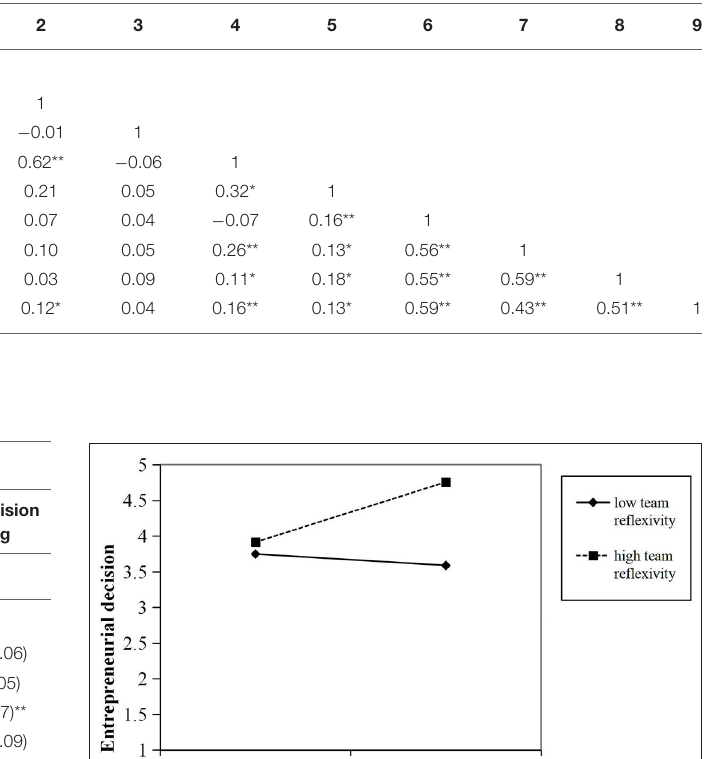
TABLE 2 | Means, SD, and correlations.